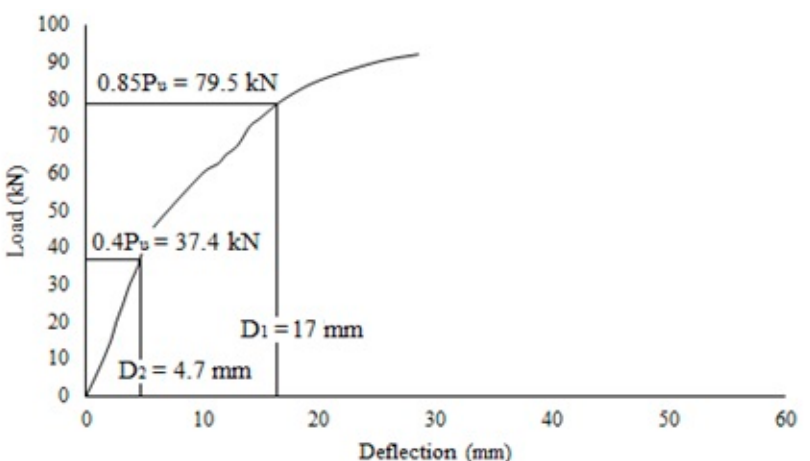
Figure 17. Ductility ratio for dovetailed profiled composite slab.